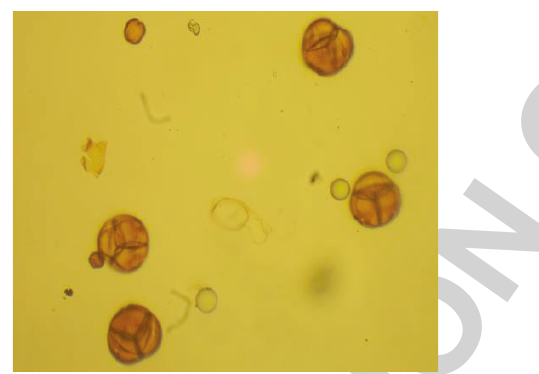
Figure 2: Pollen separated from strawberry tree ( Arbutus unedo ) honey as seen at 40x obtained after acetolysis to determination of